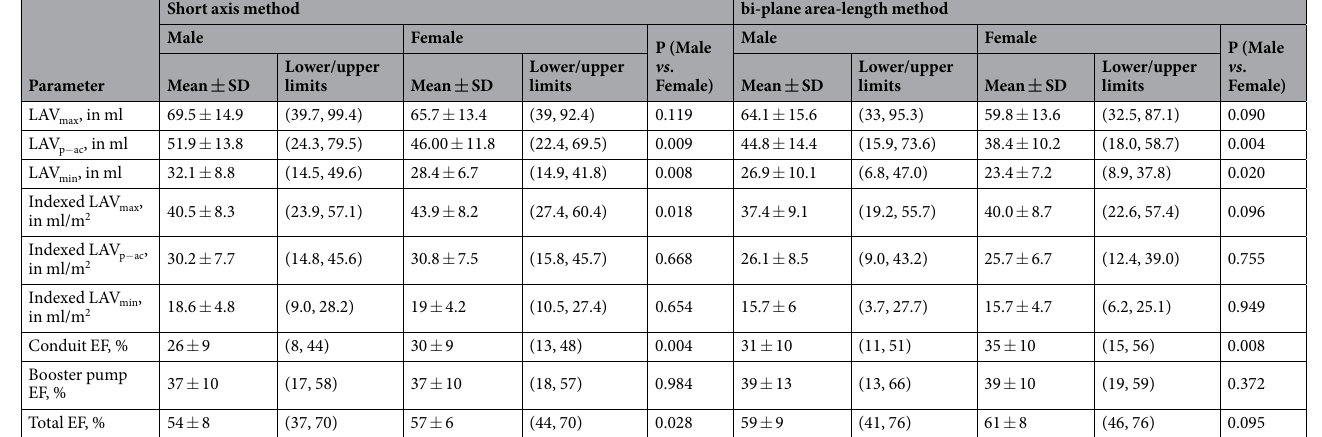
Table 4. Gender specific short axis and bi-plane area-length reference values of LA volume and phasic function (n = 135). Lower/upper limits calculated as mean ± 2 SD; LAV max , maximal left atrial volume; LAV p − ac , left atrial volume prior to atrial contraction; LAV min , minimal left atrial volume; Indexed volumes are calculated by corresponding volume in ml divided by BSA in m 2 ; Conduit EF, Conduit left atrial emptying fraction: 100% × (LAV max − LAV p − ac )/LAV max ; Booster pump EF, Booster pump left atrial emptying fraction: